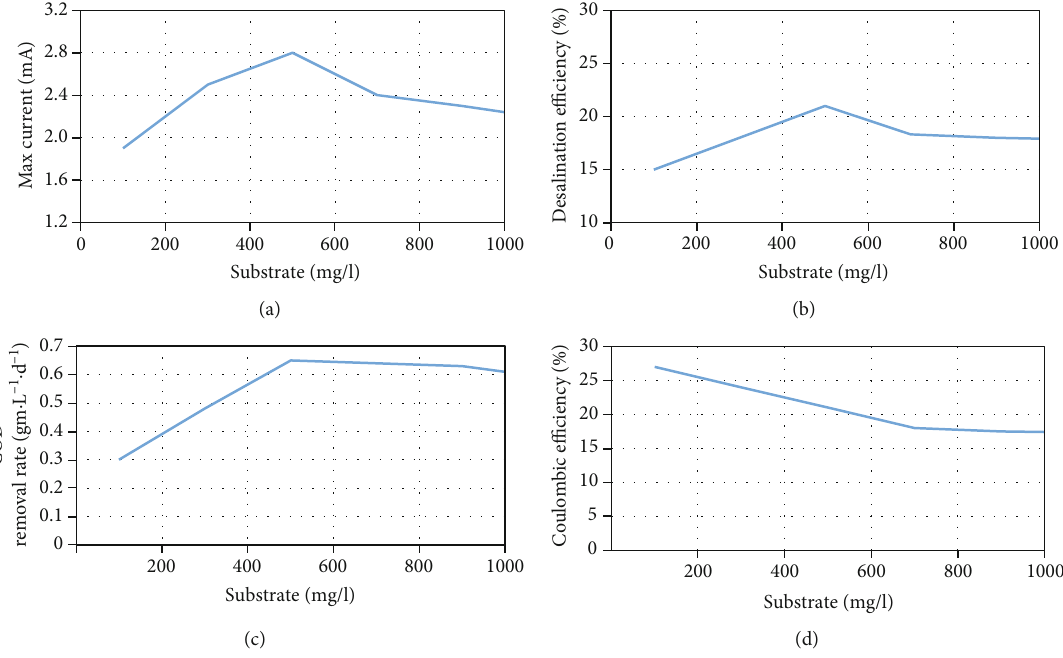
Figure 3: Model predictions in case of changing initial substrate concentration on (a) maximum current, (b) desalination e ffi ciency, (c) COD removal rate, and (d) Coulombic e ffi ciency.